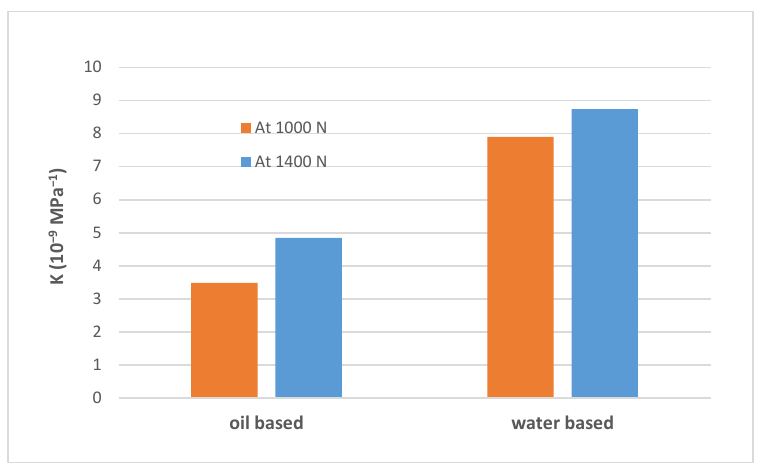
Figure 5. Wear factors of the P110 casing sample test at 115 rpm and two different loads (1400 N and 1000 N) for 190 min under oil-based and water-based wet conditions.